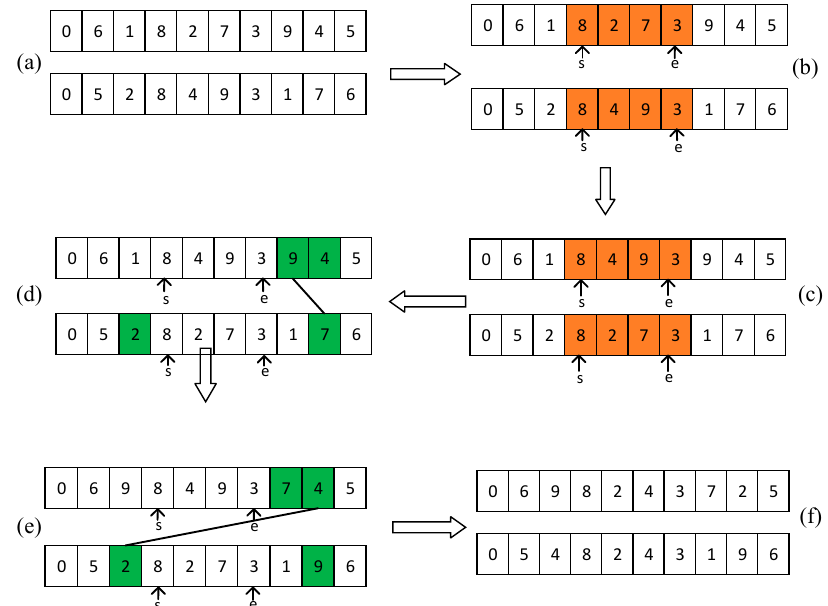
Figure 5. Heuristic crossover operation: ( a ) two adjacent individuals in a population, ( b ) determine the starting point and ending point of crossover operation in individual gene sequence, ( c ) exchange the genes from s to e between the two chromosomes, ( d , e ) the duplicate genes in each chromosome are collected from both sides of s and e , ( f ) two individuals after cross operation.